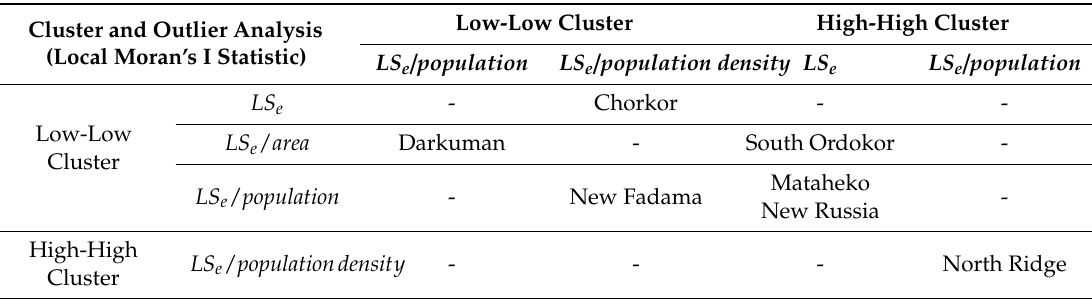
Table 7. Neighborhoods showing more than one clustering tendency for di ff erent load-shedding exposure